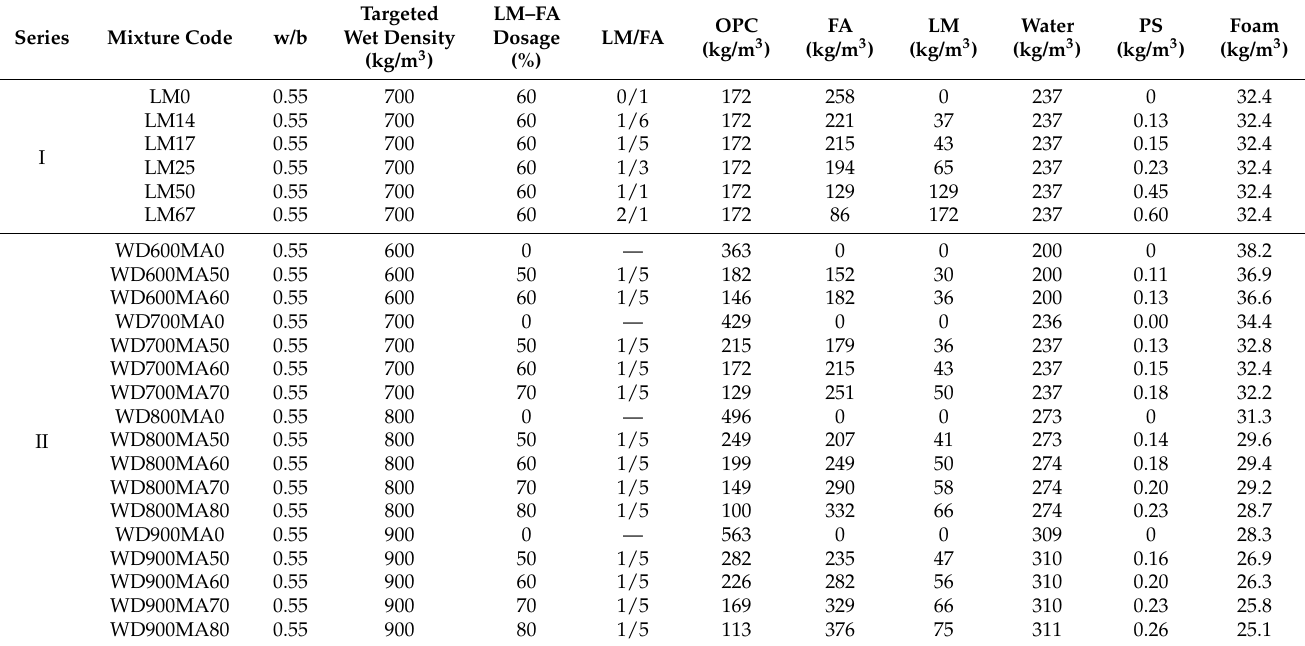
Table 2. Mixture proportions of foamed